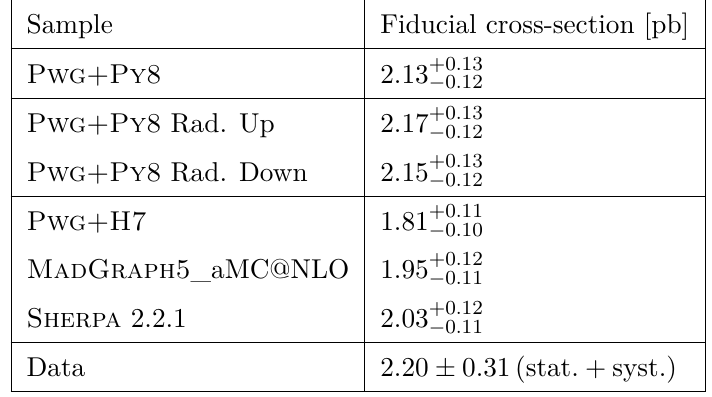
Table 16 . Comparison of the measured inclusive fiducial cross-section with the predictions from several MC generators. The uncertainty in the cross-section predicted by each NLO MC gener- ator only includes the uncertainty (due to PDFs, m